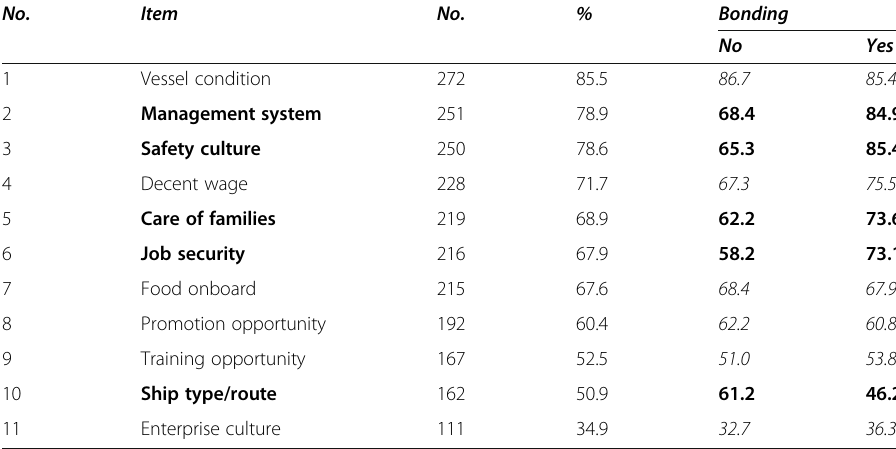
Table 6 Factors for selecting ship company by bonding